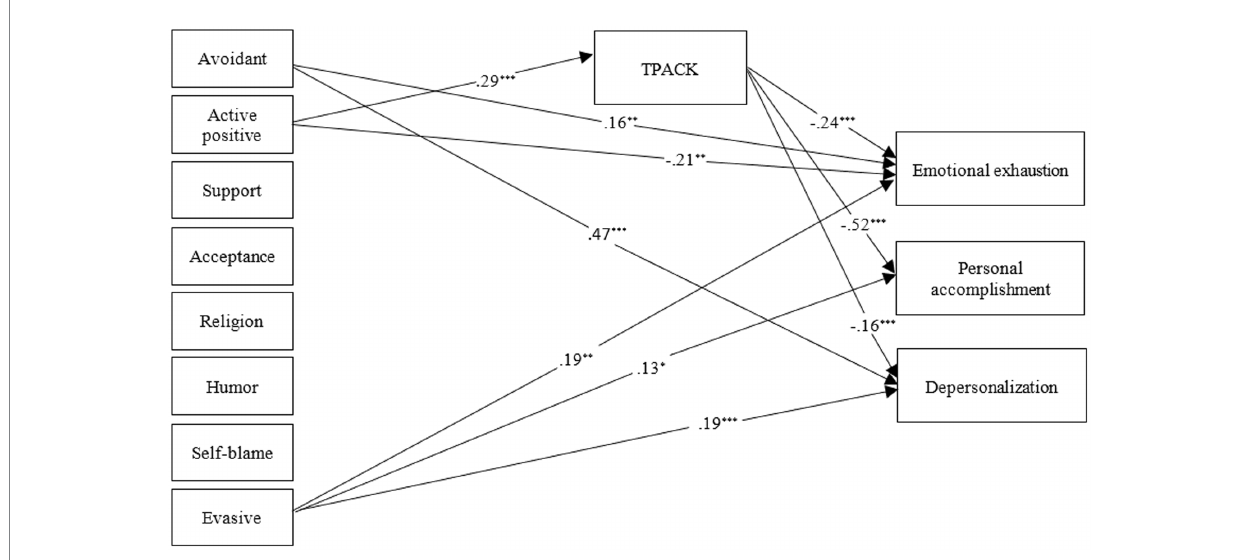
FIGURE 2 The structural equation modeling (SEM) of the interrelationship between the variables (Regression coefficients are standardized).